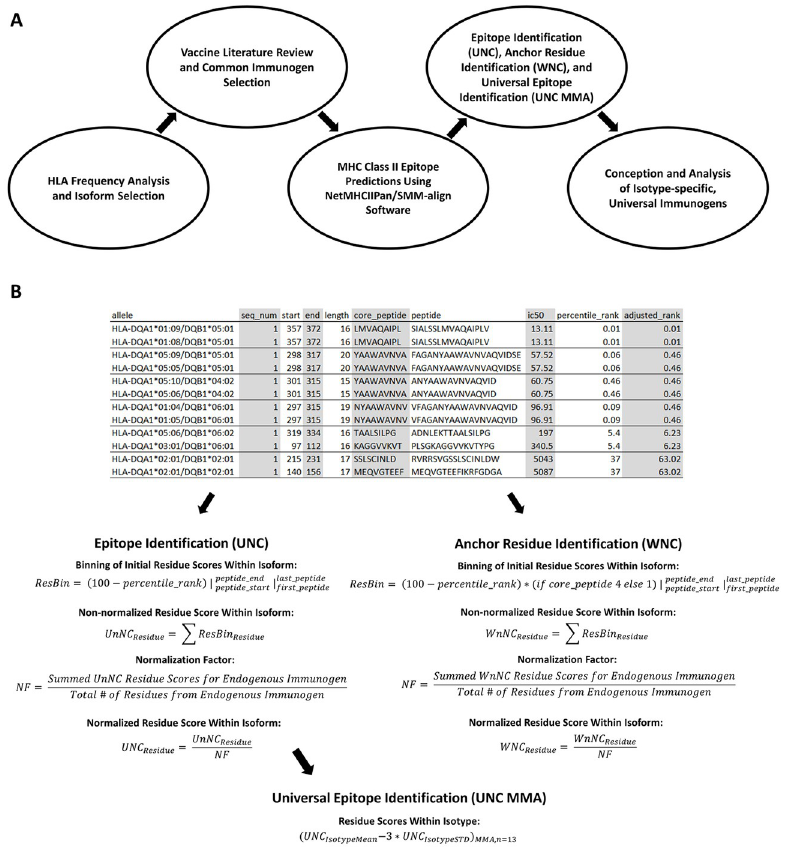
Fig 1. Schematic overview of methodology. (A) The overall study methodology and (B) the epitope scoring methodology. In the epitope scoring methodology, excerpts of NetMHCIIPan prediction output for the HLA-DQ/DT isotype/immunogen pairing are provided for reference. Binning of residue scores (calculated using epitope predictions) was achieved via iteration through epitope residues and epitopes within an isoform. This was the first step in both the UNC and WNC analysis and was performed for each isoform. Non-normalized residue scores (UnNC and WnNC) were then calculated by summing the score components of each residue bin. Normalized scores were calculated by dividing the non-normalized values by the average non-normalized residue scores for an endogenous immunogen (either HSA or MSA, depending upon the prediction isotype). UNC MMA scores were calculated by taking the mean of normalized residue scores from all isoforms within an isotype, subtracting three standard devi- ations, and applying a moving average (n = 13).